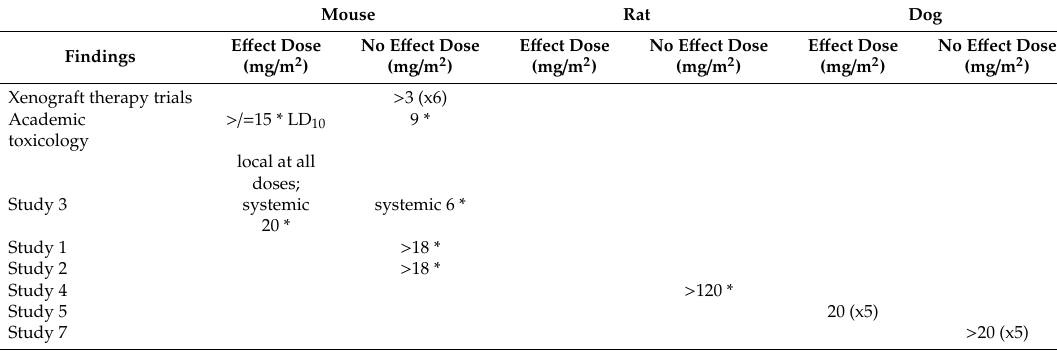
Table 2. Summary of key toxicology findings for